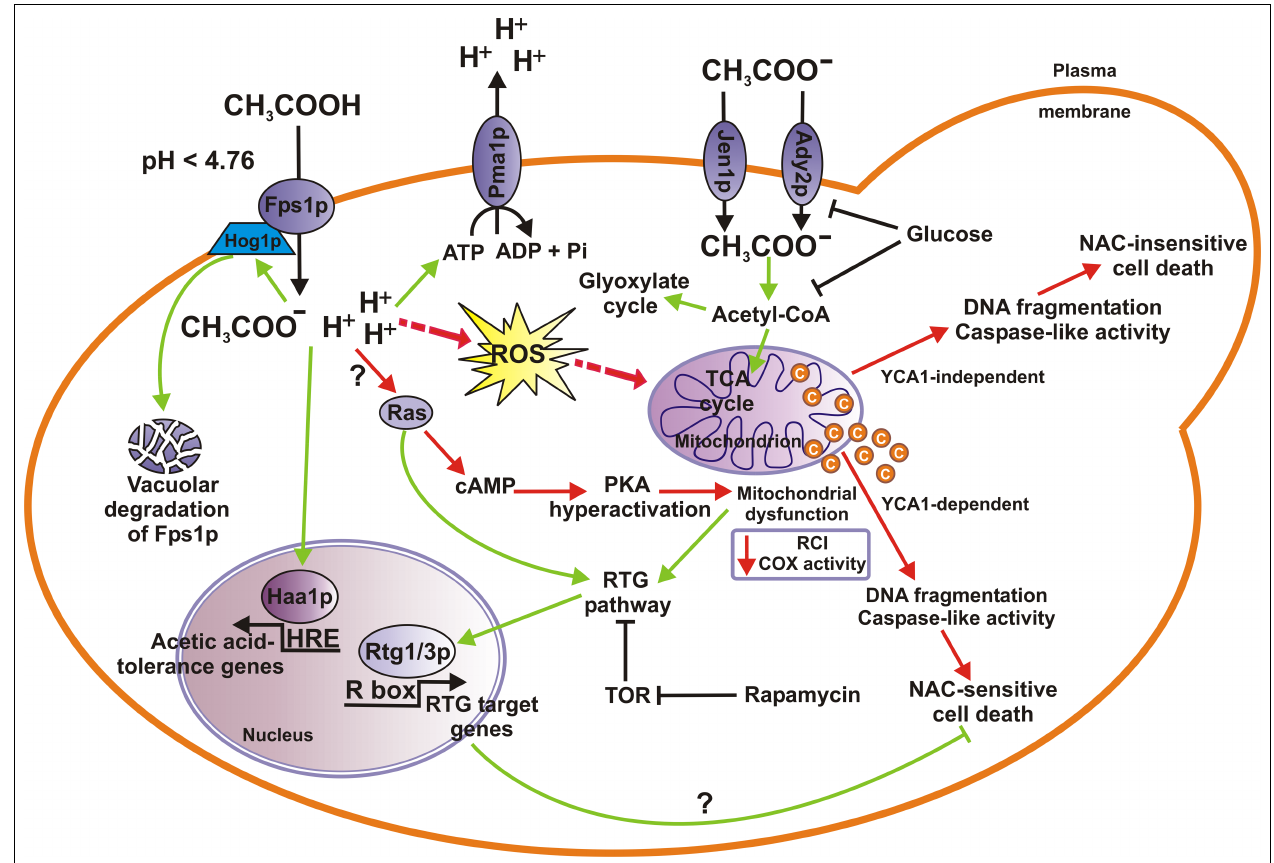
concentrations of acetic acid induce ROS accumulation, cyt c release and mitochondrial dysfunction, caspase-like activity increase leading eventually to cell death (AA-PCD), with chromatin condensation and nuclear DNA fragmentation occurring as PCD hallmarks. AA-PCD can occur in YCA1 -dependent or YCA1 -independent manner. RTG signaling pathway is proposed to be activated in certain growth conditions causing AA-PCD resistance and cell adaptation to acetic acid stress (see text for details). RTG pathway is linked toTOR and Ras signaling pathways, where the former has an inhibitory effect on Rtg1/3-dependent gene expression, and the latter enhances retrograde response. Hyperactivation of Ras–cAMP–PKA pathway can lead to mitochondrial dysfunction, ROS production and apoptosis. Cell adaptation and acetate metabolic pathways (green arrows) and AA-PCD pathways (red arrows) are shown. COX, cyt c oxidase; RCI, respiratory control index; ROS, reactive oxygen species;TCA, tricarboxylic